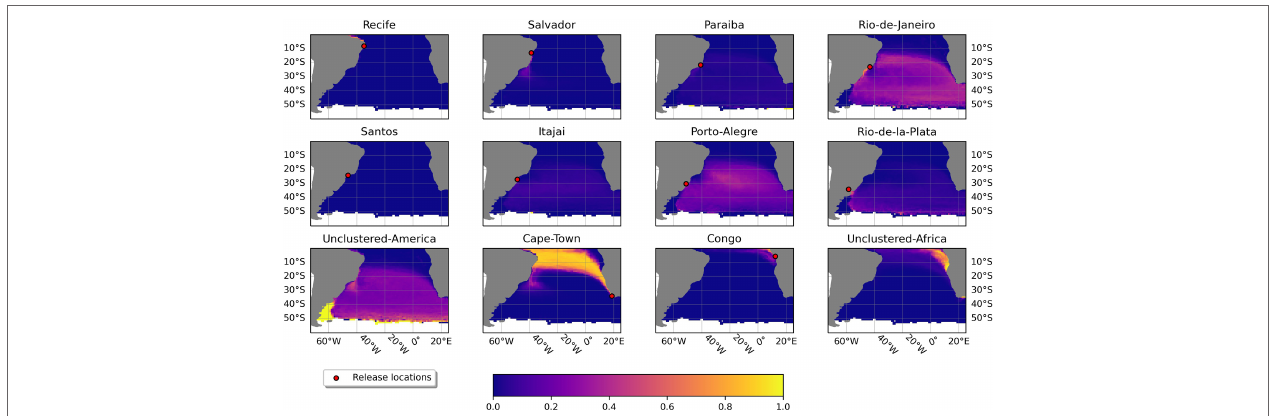
FIGURE 3 | Posterior probability maps, averaged over 3.4 years, showing p(R i |S loc ), the probability of finding a particle from a specific cluster at any point in the South Atlantic. Each map displays the probability for a specific cluster in all the bins of the domain. The red dots indicate the locations of the clusters from which the particles entered the ocean. At each location, the sum of posterior probability of the twelve clusters is 1.